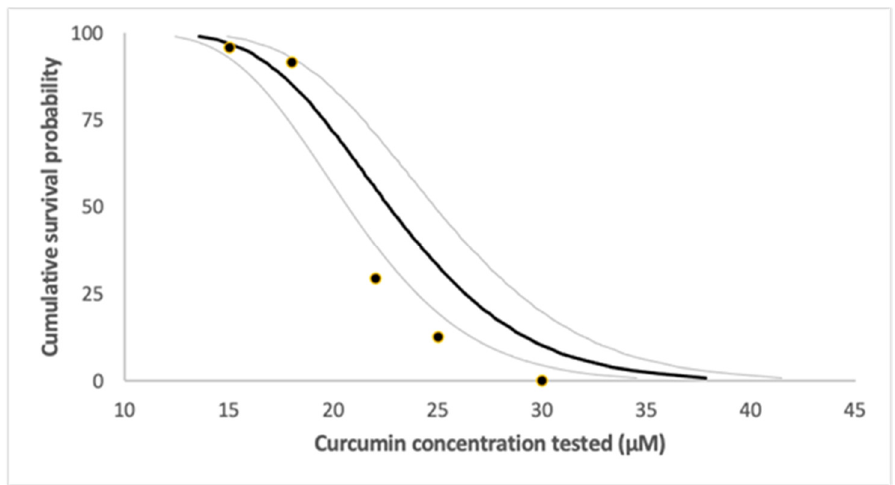
Figure 11. Lethal concentration determination.